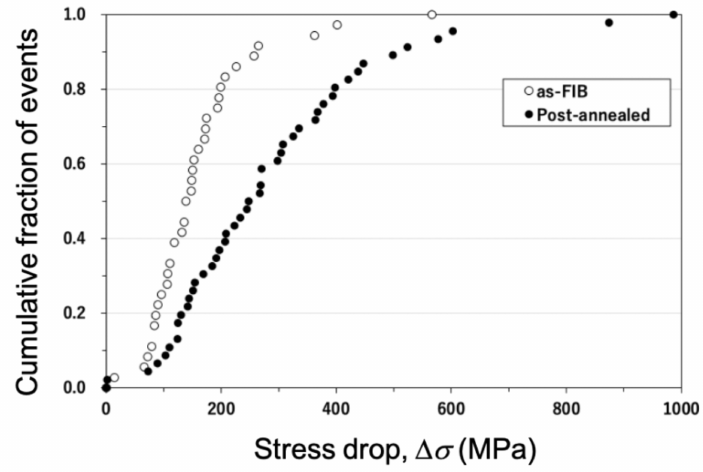
Figure 7. Cumulative distribution of the measured stress drop ( ∆ σ ) detected in the TEM in situ compression measurement. Open and solid circles represent the events detected in the as-FIB and post-annealed Al pillars,